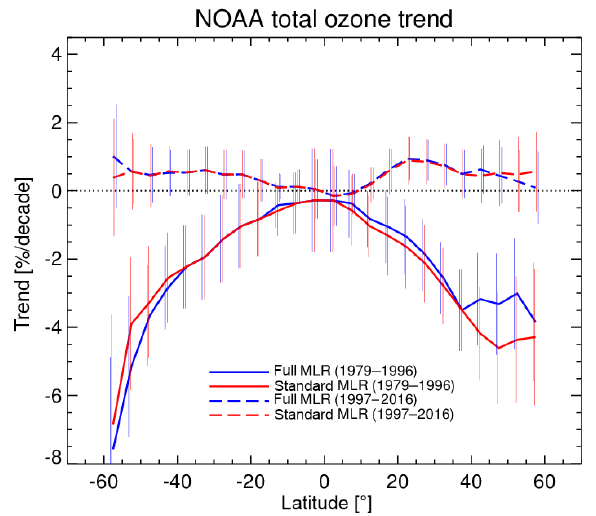
Figure 9. Linear trends in %decade − 1 before and after 1996 by applying the standard (red) and extended MLR (blue) to NOAA data. Uncertainties are given as 2 σ . Dashed lines are the trends after 1996 and solid lines before